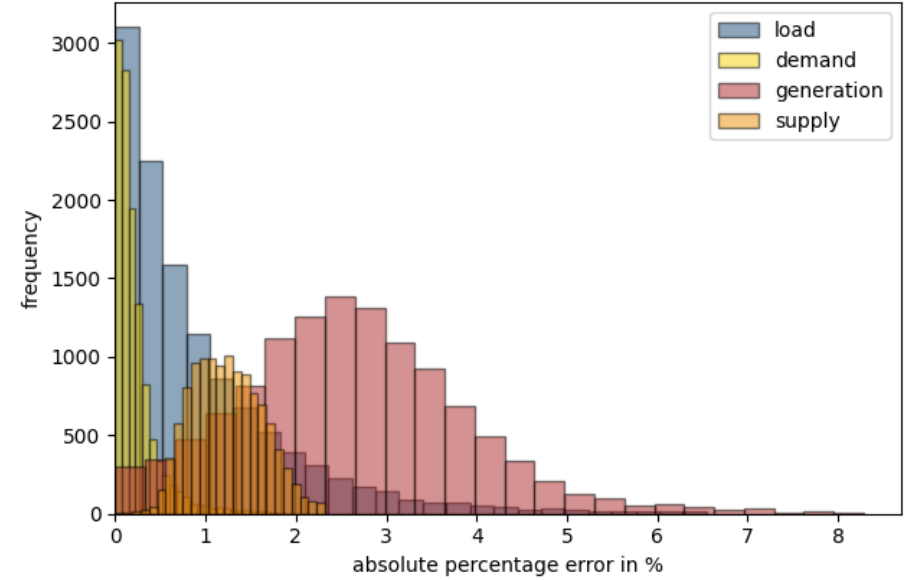
Figure 9. Distribution of prediction errors per described feature of all German municipalities ( n = 11,977) with 50 typical hours neglecting values outside the range between the 1st and 99th percen- tiles.